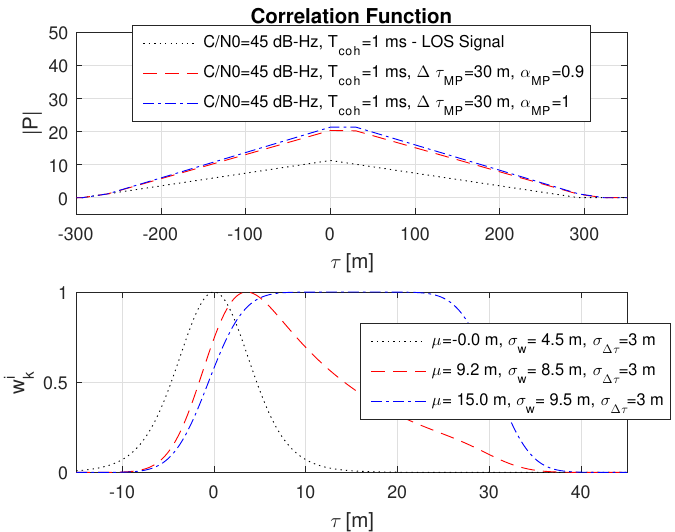
Figure 11. An increase of the multipath amplitude α MP shifts the weighted mean µ and increases the weighted standard deviation σ w . The probability function naturally covers the uncertainty also in the case of α MP = 1, when the multipath signal is as strong as the LOS signal. The dotted black line refers to the LOS